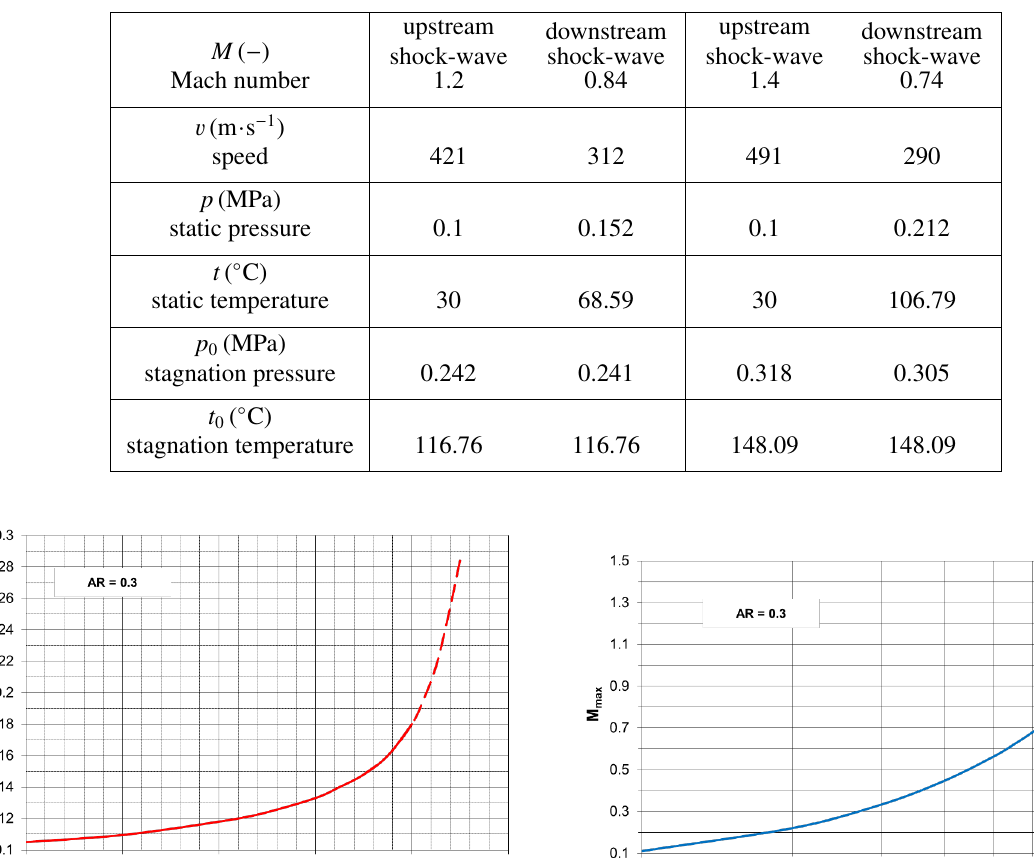
Table 3. Flow properties across the normal shock wave for two selected supersonic upstream Mach numbers.